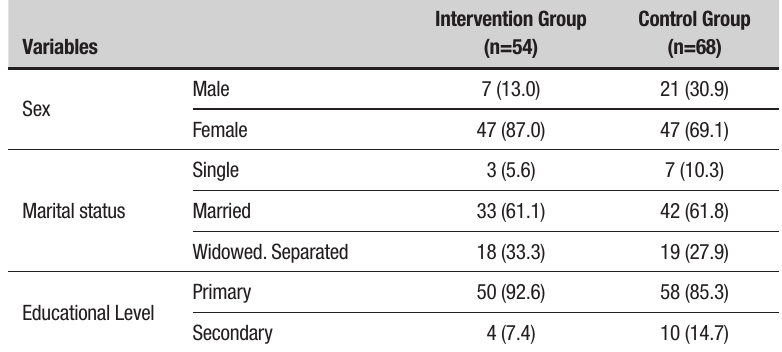
Table 1. Frequencies and percentages for sociodemographic